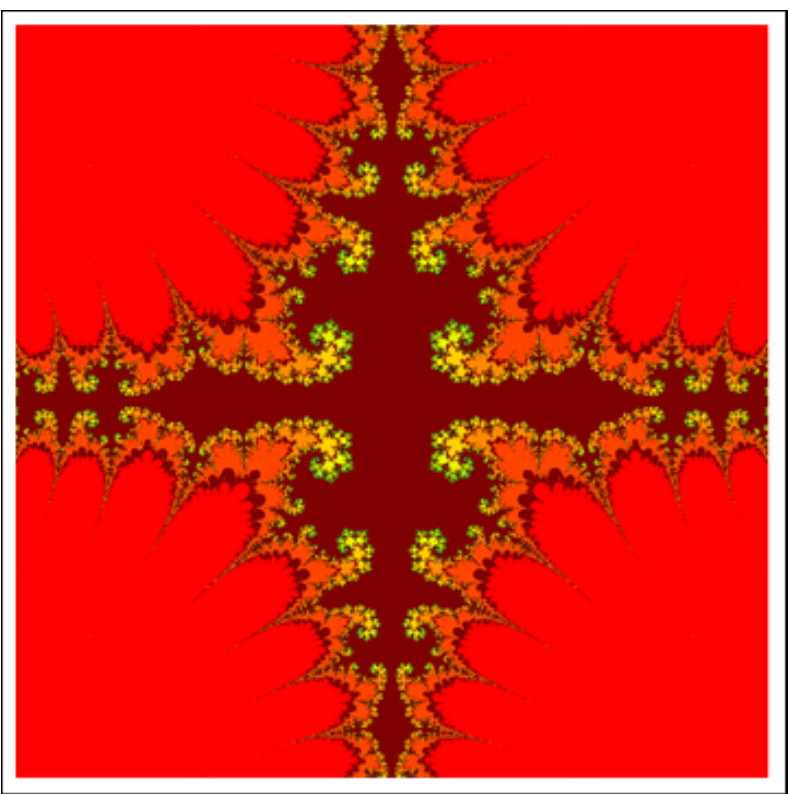
Figure 4. J-set for τ ( z ) = sin ( z 2 ) + c via DKIS. The image execution time is 248.281 s.